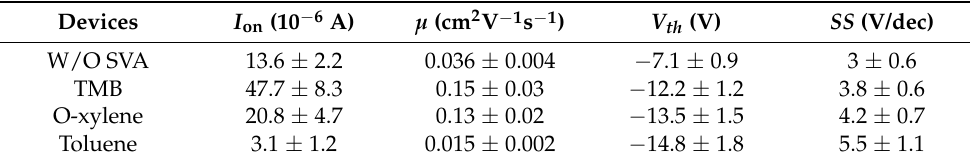
Table 1. Summary of the OTFT parameters.